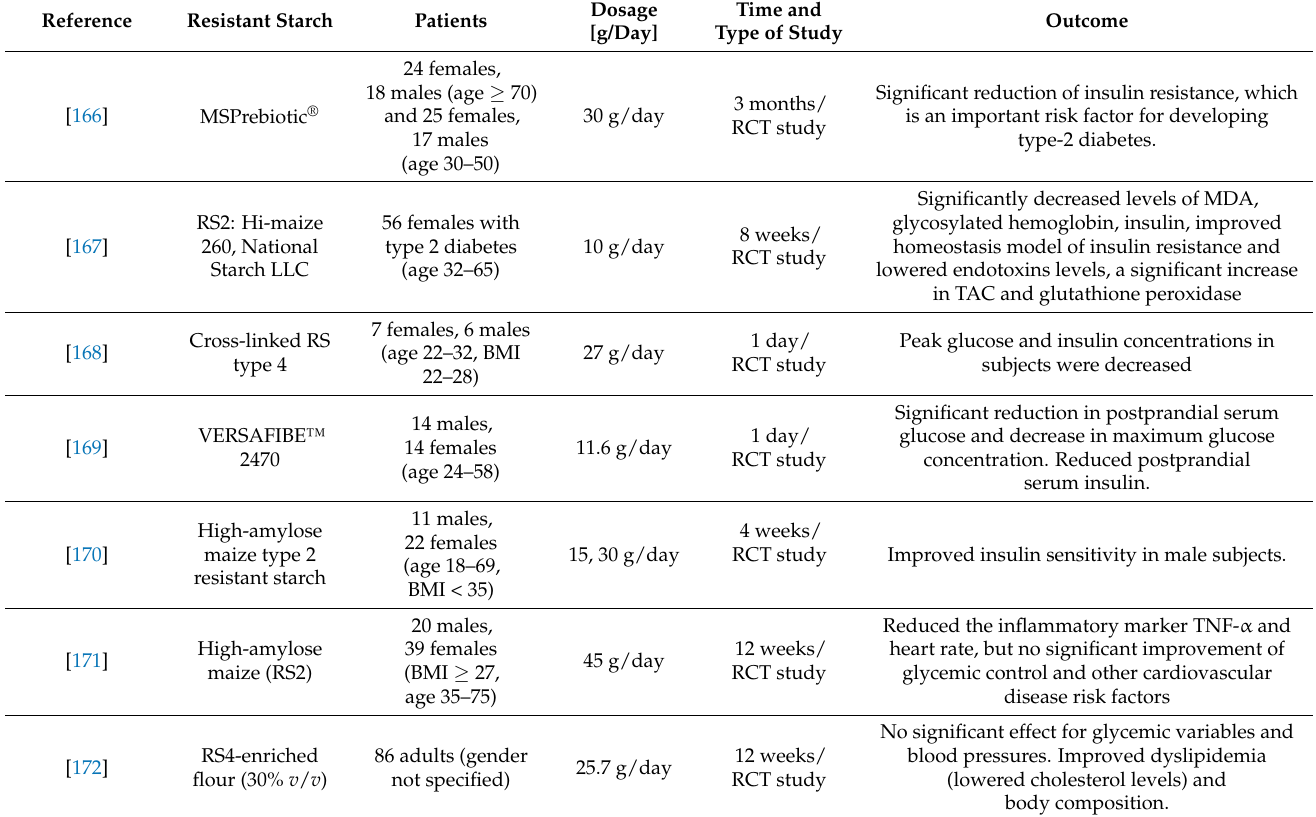
Table 5. Clinical trials on the effect of resistant starch on various health